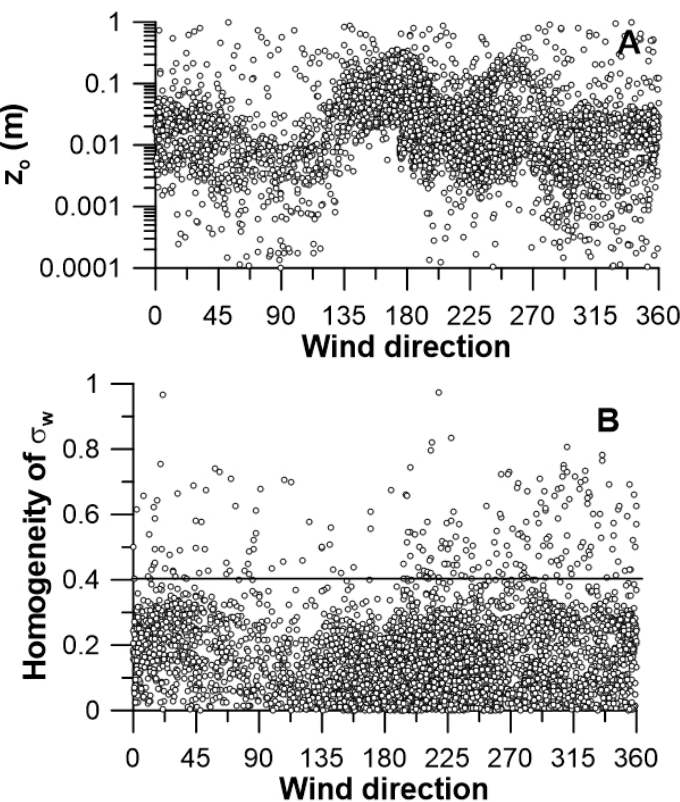
Figure 2. Turbulence characteristics with wind direction. The variation in the calculated half-hour mean z o ( A ) and homogeneity of half-hour mean σ w ( B ) are indicated based on measurements of the north sonic anemometer. The influence of the corral infrastructure on the roughness is evident for winds coming from the